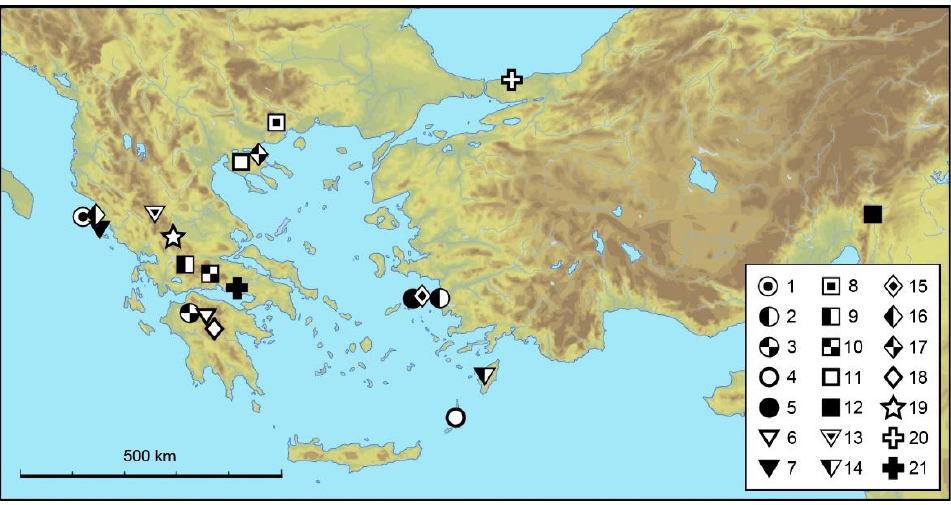
Figure 4. Distribution map of genus Prioniomus . 1: P. abnormis ; 2: P. aegeicus ; 3: P. antonellae ; 4: